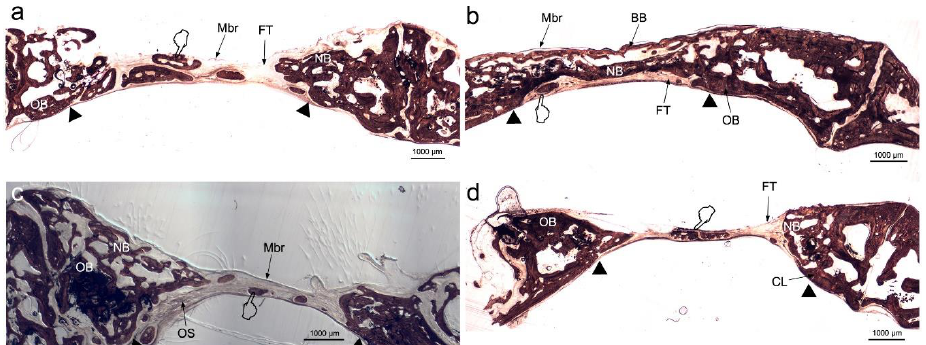
alongthemarginofcalvarialdefect(arrowhead),andwithinthedefect. BB ,bonybridging; FT bridging; FT , fibrous tissue; Mbr , membrane; NB , new bone; OS , osteoid; OB , old bone, cement line ( CL ). Pointers mark scattered bone islands, indicating with new bone.